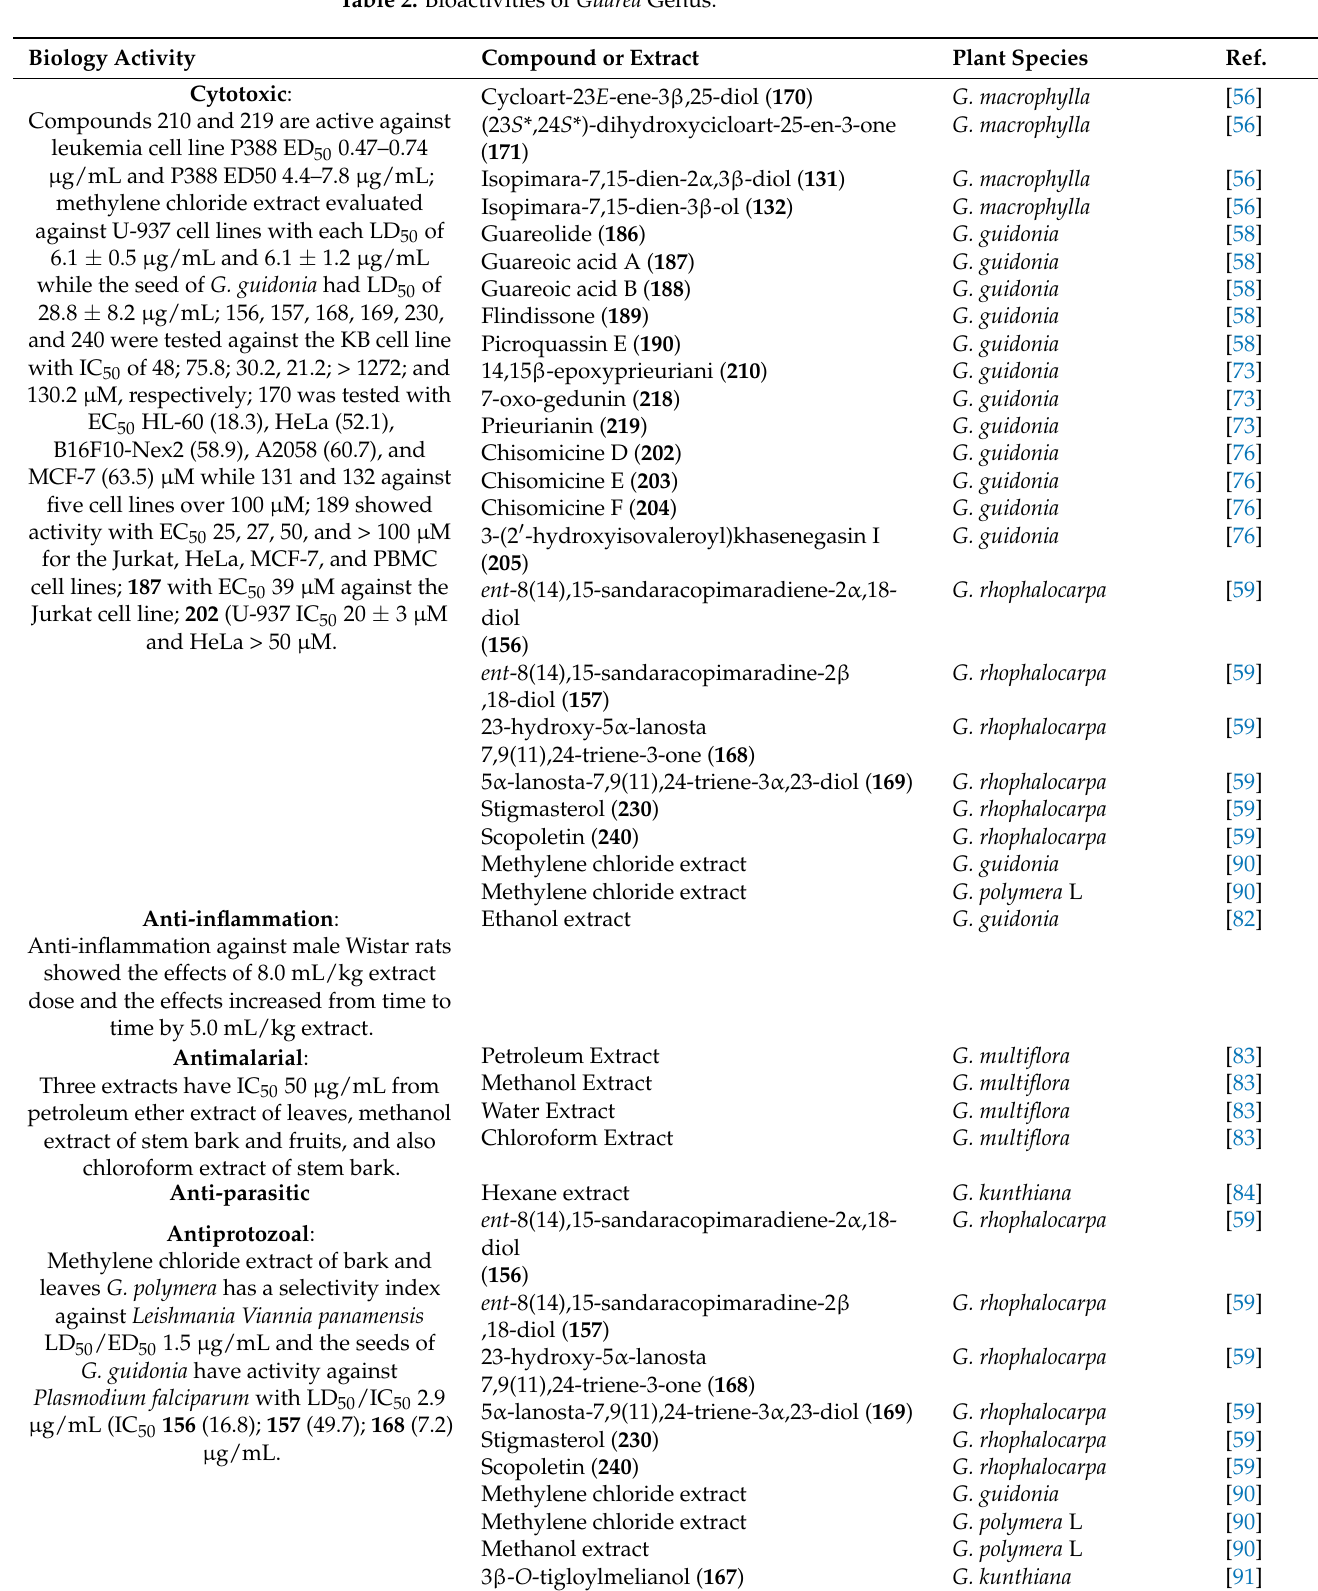
Table 2. Bioactivities of Guarea